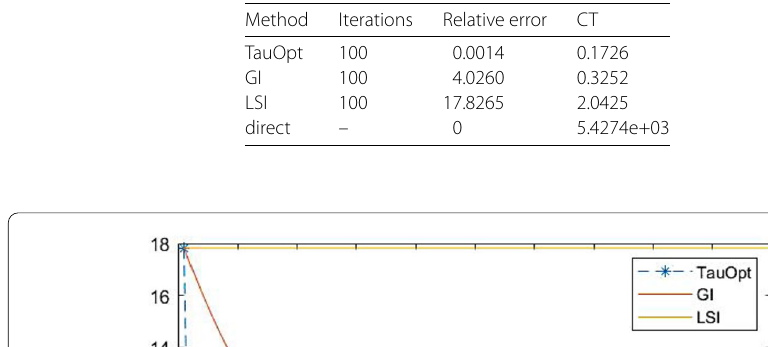
Table 1 Relative errors and CTs for Ex. 5.1